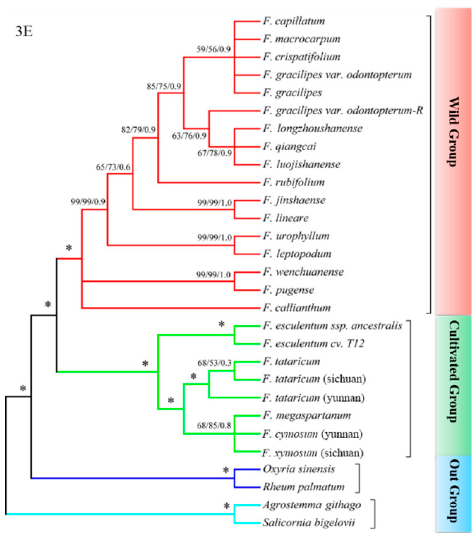
Figure 3. Phylogenetic analysis of genus Fagopyrum based on plastid DNA barcode. The figure ( A – E ) represent matK , ndhA intron, rbcL-accD , trnT-trnL and psbE-psbL , respectively. The * symbols in the phylogenetic tree show that the support rate of this branch is 100/100/1.0.